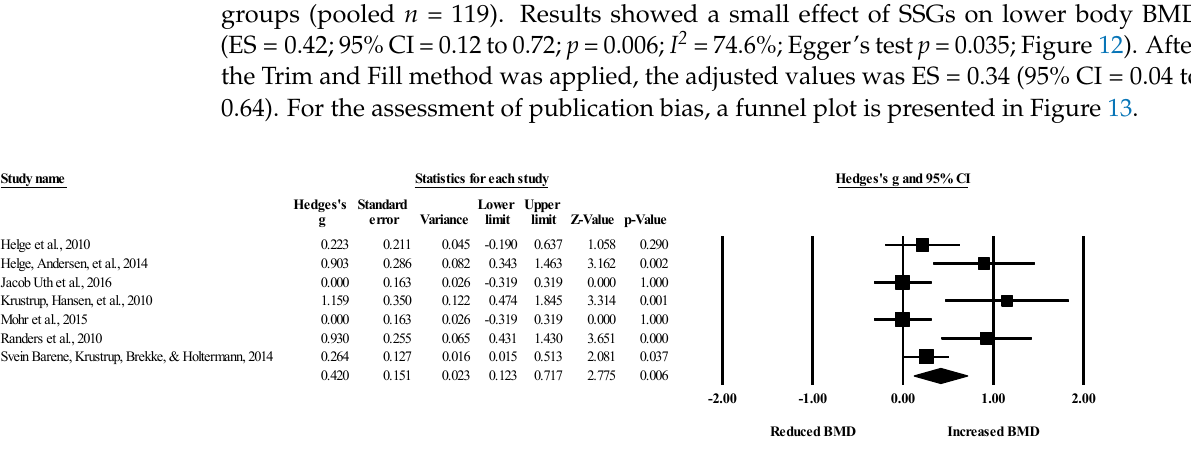
Figure 11. Funnel plot for changes in lower-body bone mineral density in untrained adults after a training program based on soccer small-sided games compared to an active control condition. White circles: observed studies.